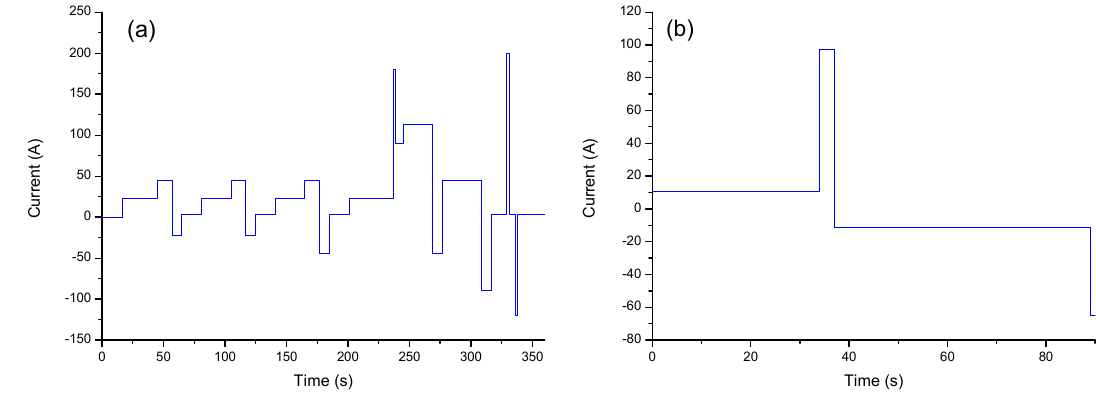
Figure 1. ( a ) Charge depleting (CD); and ( b ) charge sustaining (CS) current micro-cycles.